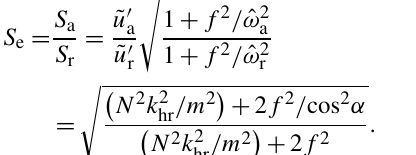
Figure 2. Procedure of deriving winds and shears induced by a GW profile pair (red and black lines indicate the results from T (cid:48) T (cid:48) , respectively). (a) T (cid:48) and T (cid:48) were measured at (42.55 ◦ N, 56.48 ◦ E, 07:16UT) and (44.97 ◦ N, 56.34 ◦ E, 07:18UT), respectively, on w2 w1 w2 1 January 2018. The distance between the two adjacent profiles is 269.8km. (b, c) The GW induced winds in the along- and cross-track directions, respectively. (d, e) The GW induced shears in the along- and cross-track directions, respectively. (f) The GW-perturbed shear ( S) . All panels have the same y -axis